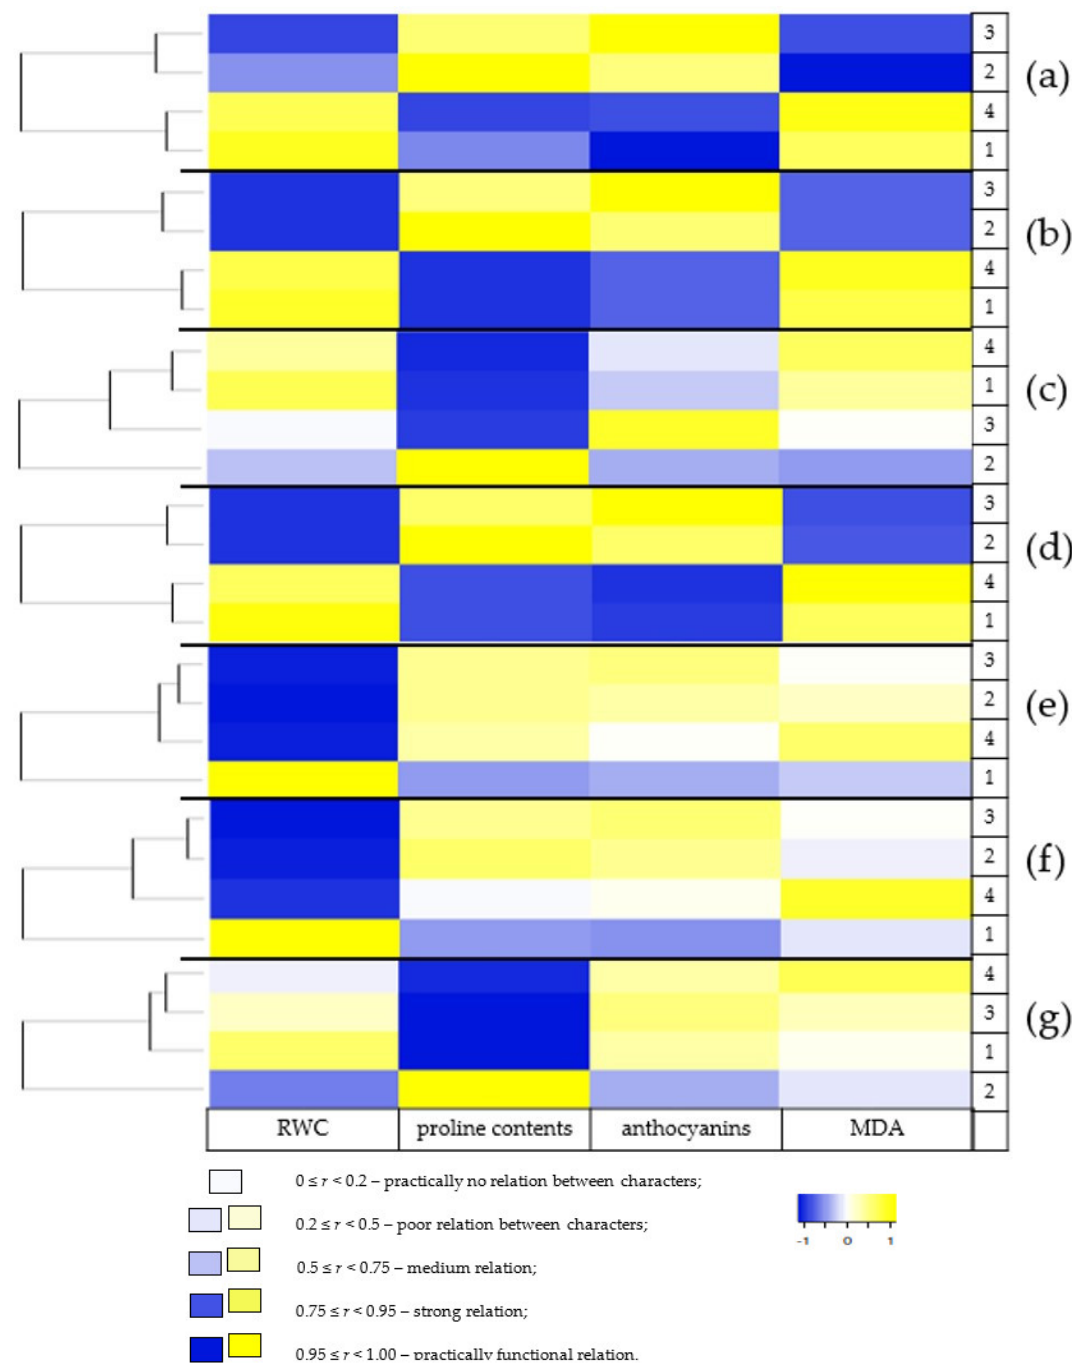
Figure 3. Correlation coefficients between features analyzed for stressed cultivars; ( a ) ‘Franckenkorn’; ( b ) ‘Oberkulmer’; ( c ) ‘Badengold’; ( d ) ‘Ostro’; ( e ) ‘Divimar’; ( f ) ‘Schwabenkorn’ and ( g ) ‘Bogatka’. Features compared: relative water content (RWC), proline contents and anthocyanins, lipid peroxidation index (MDA). Interpretation of Pearson’s linear correlation coefficient: 0 ≤ p < 0.2—practically no relation between characters; 0.2 ≤ p < 0.5—poor relation between characters; 0.5 ≤ p < 0.75—medium relation; 0.75 ≤ p < 0.95—strong relation; 0.95 ≤ p < 1.00—practically functional relation.